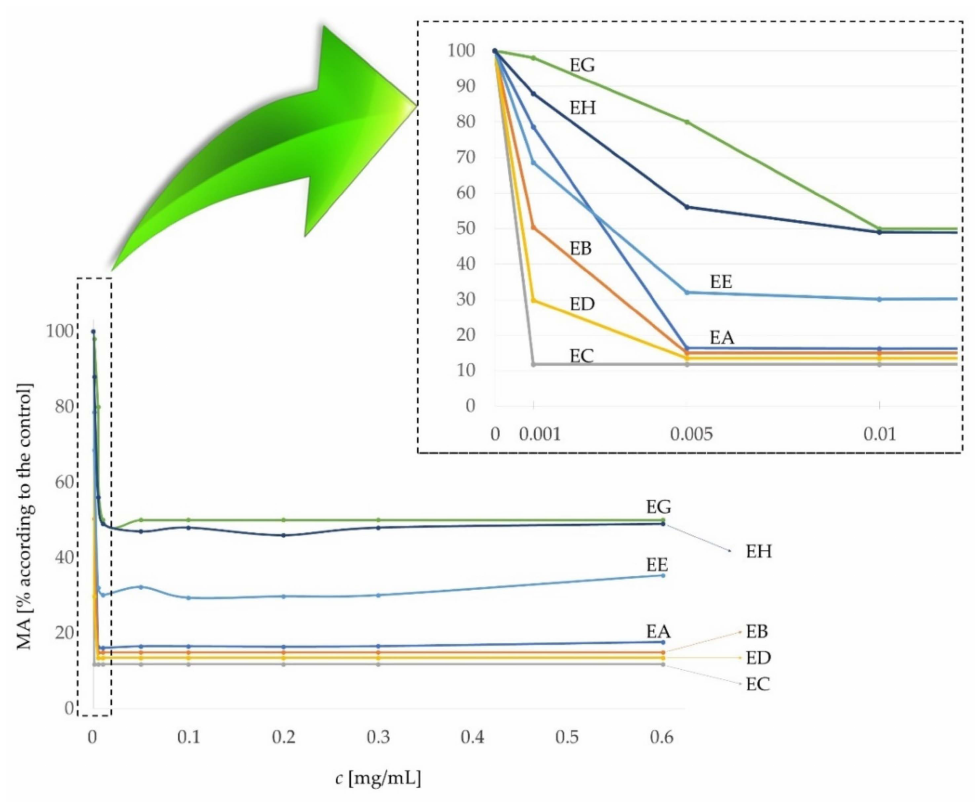
Figure 4. Metabolic activity of melanoma cells WM-266-4 at different concentrations of extracts (EA, EB, EC, ED, EE, EG and